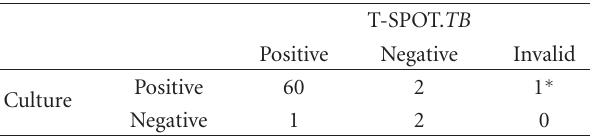
Table 1: Overall agreement between TB culture and T-SPOT. TB